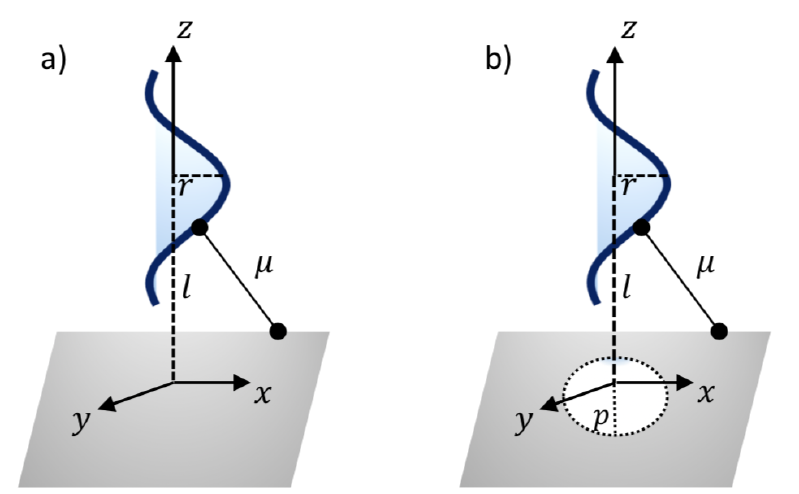
Figure 2. Illustration of ssDNA molecule: ( a ) interacting with a sheet and ( b ) penetrating a gap